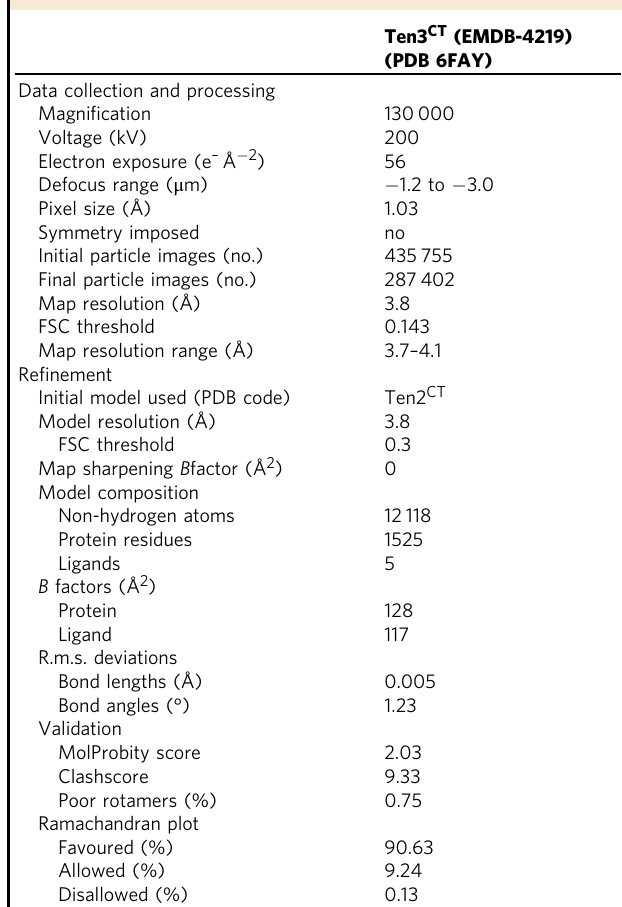
Table 2 Cryo-EM data collection and re fi nement